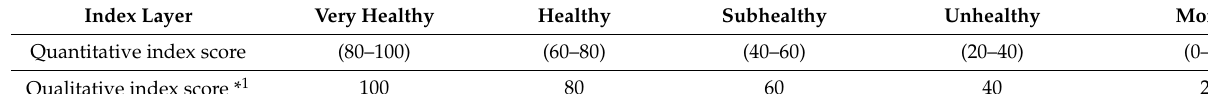
Table 2. Criteria for ecological health assessment index system of small hydropower